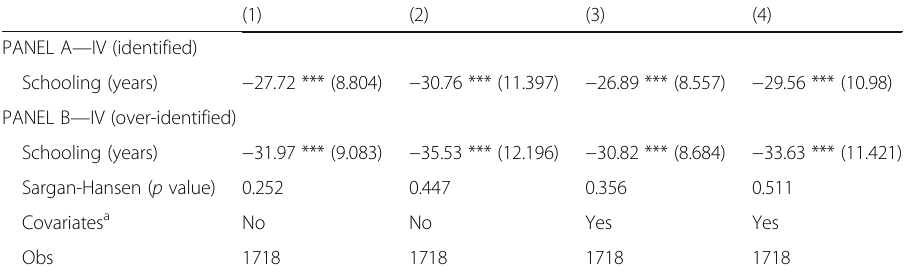
Table 8 The effect of years of schooling on teenage fertility rates (human capital effect). 2SLS estimates — second stage (Eq. 1)